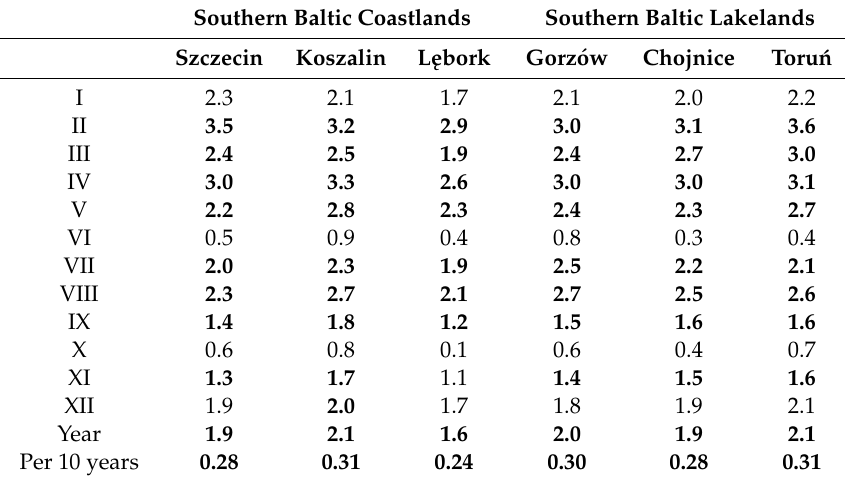
Monthly and annual values of air temperature ( ◦ C) changes calculated from linear regression equations, 1952–2018 (bold font indicates values that are statistically significant at a level of 0.05) (calculated based on data obtained from the Polish Institute of Meteorology and Water Management—National Research Institute